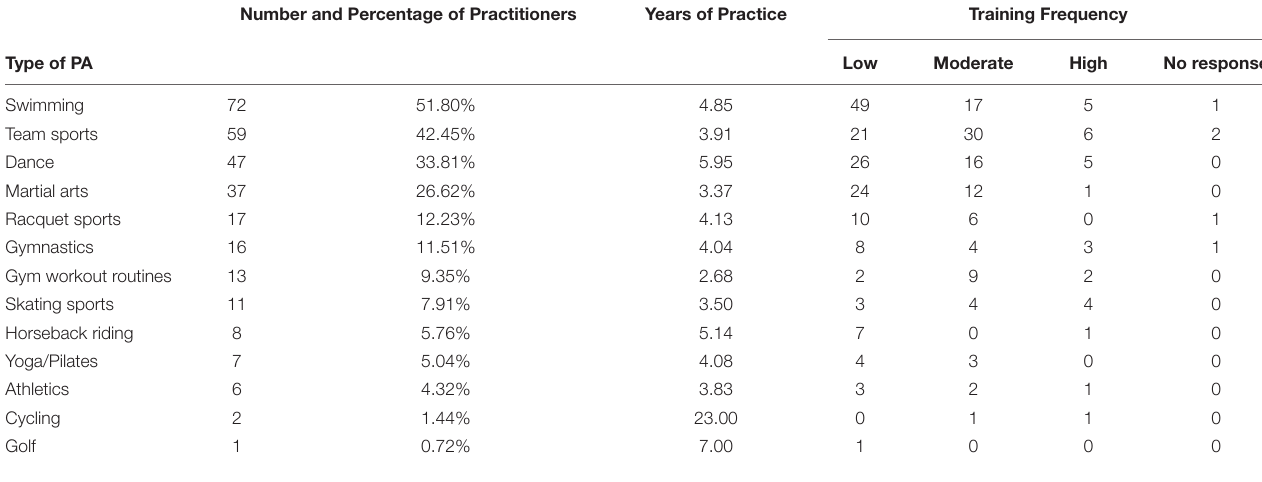
TABLE 1 | Characterization of the sample in terms of physical activity (PA) practiced ( n = 139). Number and Percentage of